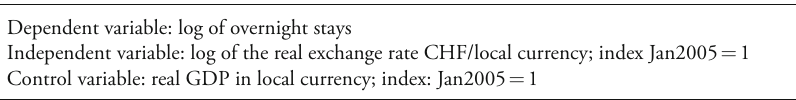
Table 3: Country